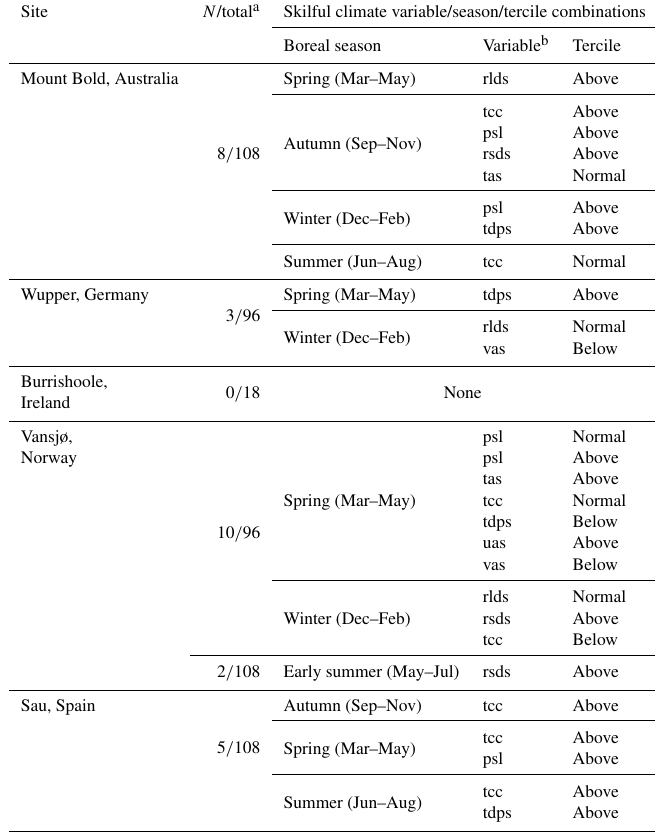
Table A1. Climate variables, seasons, and terciles for which SEAS5 had significant skill, as assessed by comparison to ERA5 over the period 1993–2016. Note: N is the number of windows of opportunity; total is the total number of variable, season, and tercile combinations